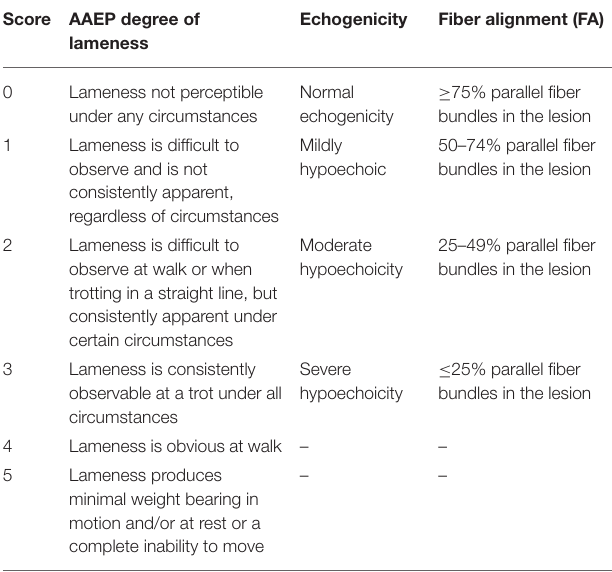
TABLE 1 | Clinical and ultrasonographic scores to assess lameness, echogenicity and fiber